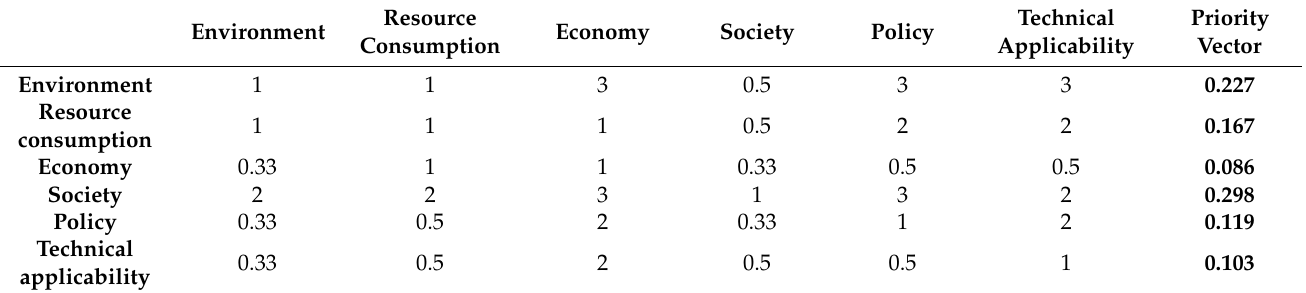
Table 8. Pairwise comparison matrix.